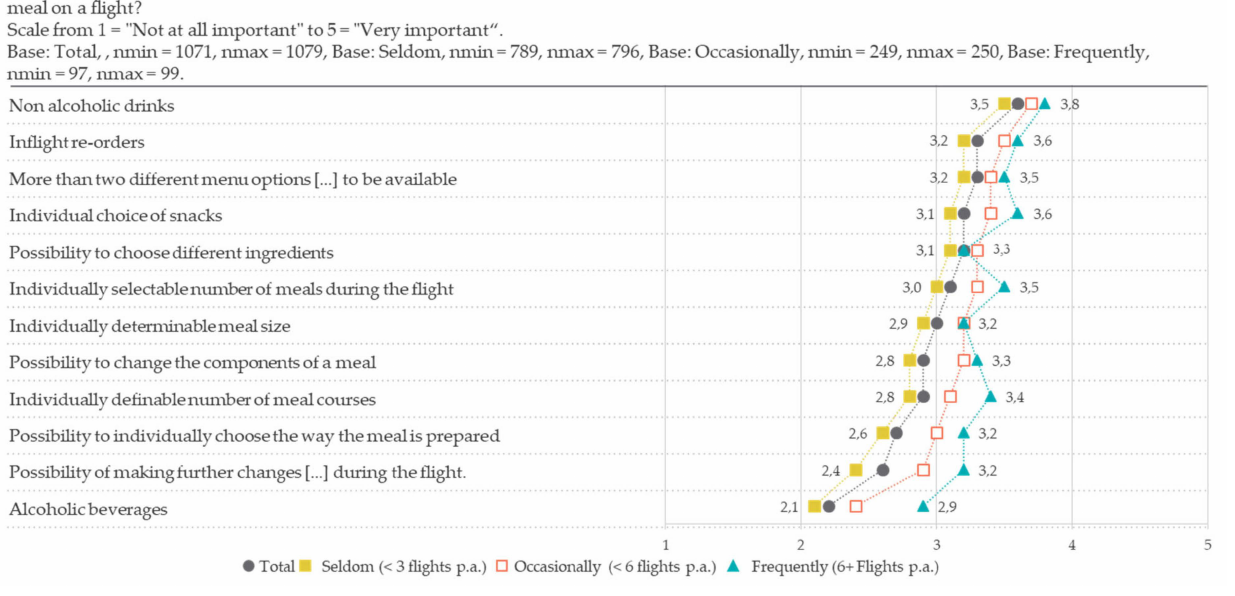
Figure 9. Importance of individualisation aspects (in Avg.) by flight frequency. The respondents were also asked about their willingness to pay a surplus for cus- tomised meals; from 73% of the respondents, 69% of them were willing to pay up to EUR 4 extra to customise a menu, as shown in Figure